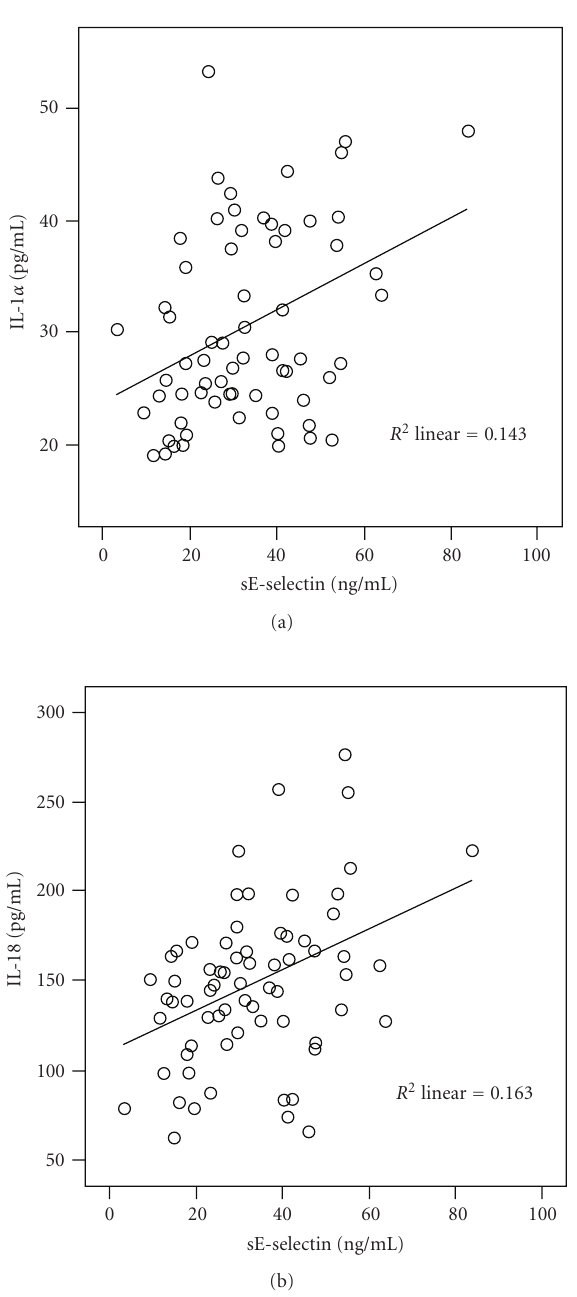
whether IL-1 α is involved into such changes. Future studies will have to elucidate this